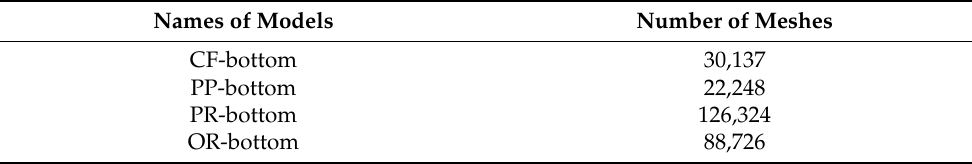
Table 3. The number of meshes for the models. Names of Models Number of Meshes CF-bottom 30,137 PP-bottom 22,248 PR-bottom